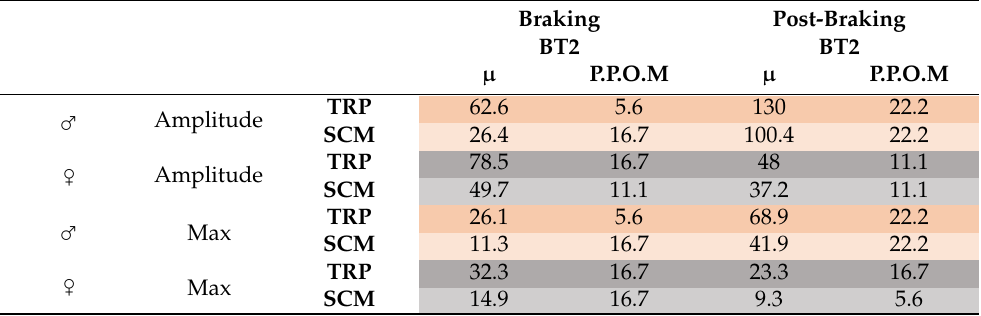
Table 5. sEMG parameters for BT2 (mean of the amplitude and maximum value reached) compute in the braking and post-braking phases (phase 2 and phase 3) sorted by genre ( Percentage of People Over the Mean; µ : mean value of the amplitude after normalisation (%).